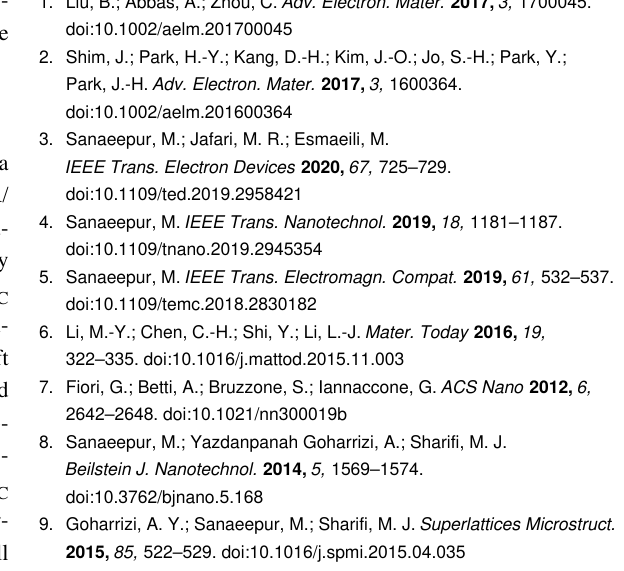
(at least up to a bias voltage of 250 mV, which is considered in this work). The absence of a local quantum well in the left spac- er region (for bias voltages ranging from 0 to 250 mV) causes the transmission peak to vanish at larger bias voltages with respect to the defect-free structure. Therefore, the peak values of current and voltage are increased with respect to defect-free structure (Figure 7a). A C N defect in the left barrier region, besides reducing the bandgap, slightly lowers the conduction band edge (Figure 3f). This has a twofold effect: a small down- ward shift of the resonant energies of the well and a slight increase in transmission probabilities over the left barrier (Figure 7b), which in turn cause I p to slightly increase and V p to slightly decrease, as illustrated by the yellow curve in Figure